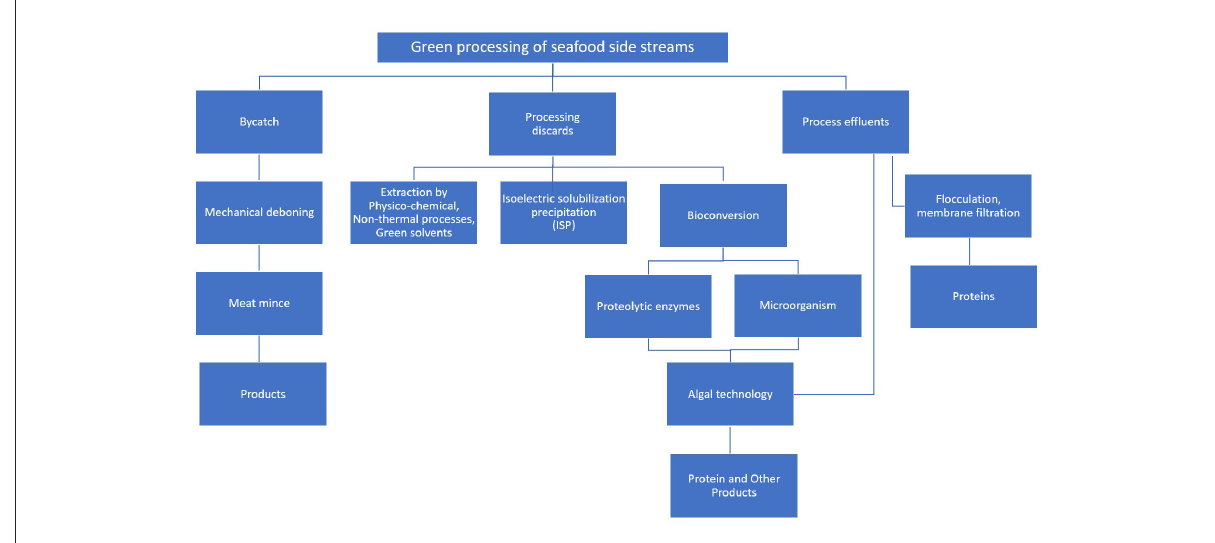
FIGURE2 Green processes for extraction of proteins from seafood side